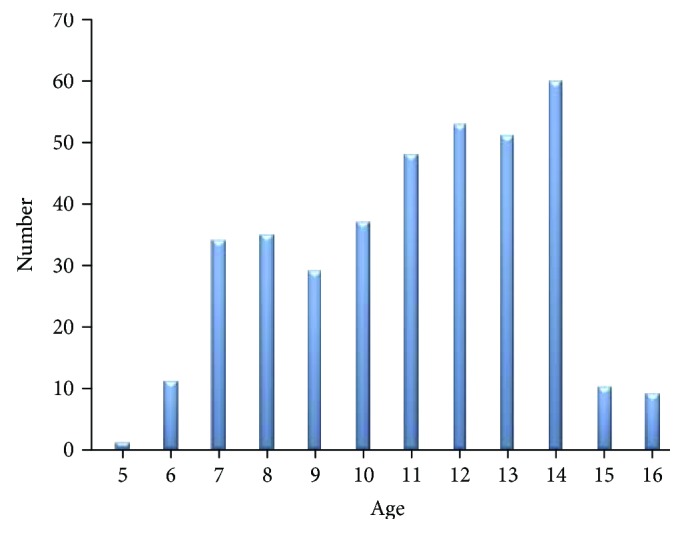
Distribution of participants by age.